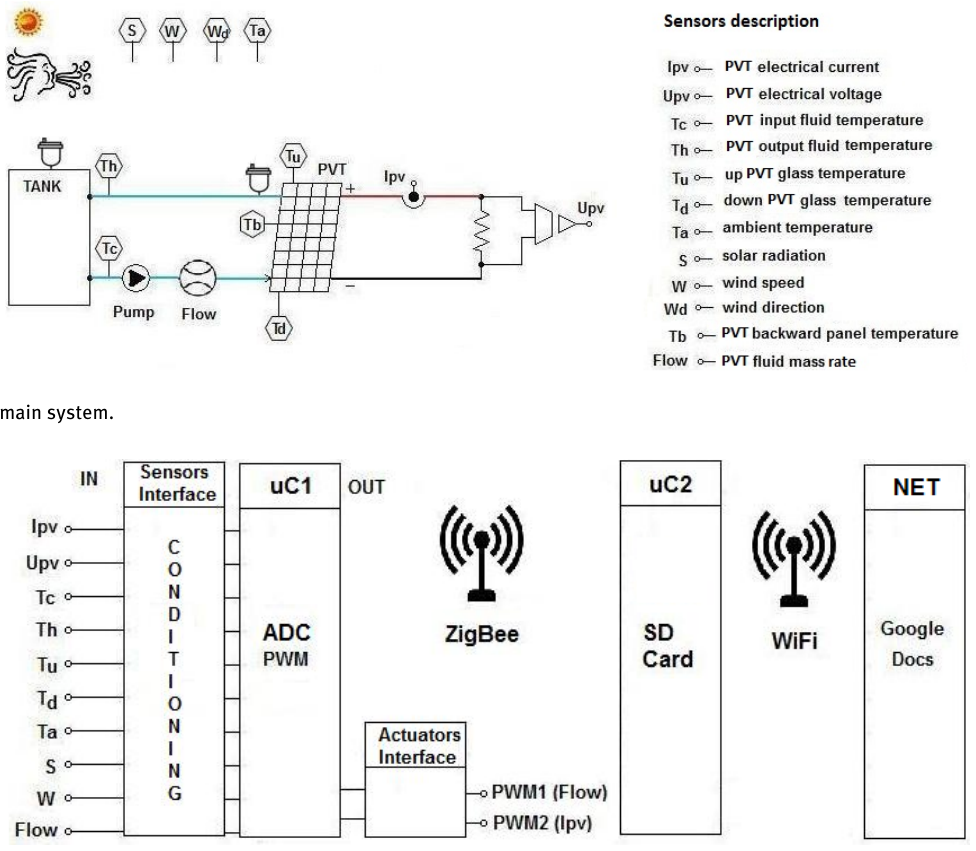
Figure 2: PVT conditioning and transmission subsystem.